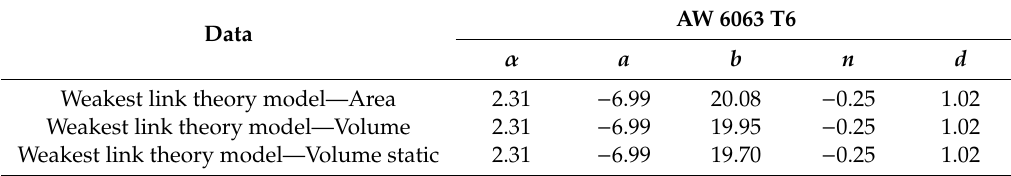
Table 6. Values of the 3-parameters Weibull models for S355J2 + C. Data